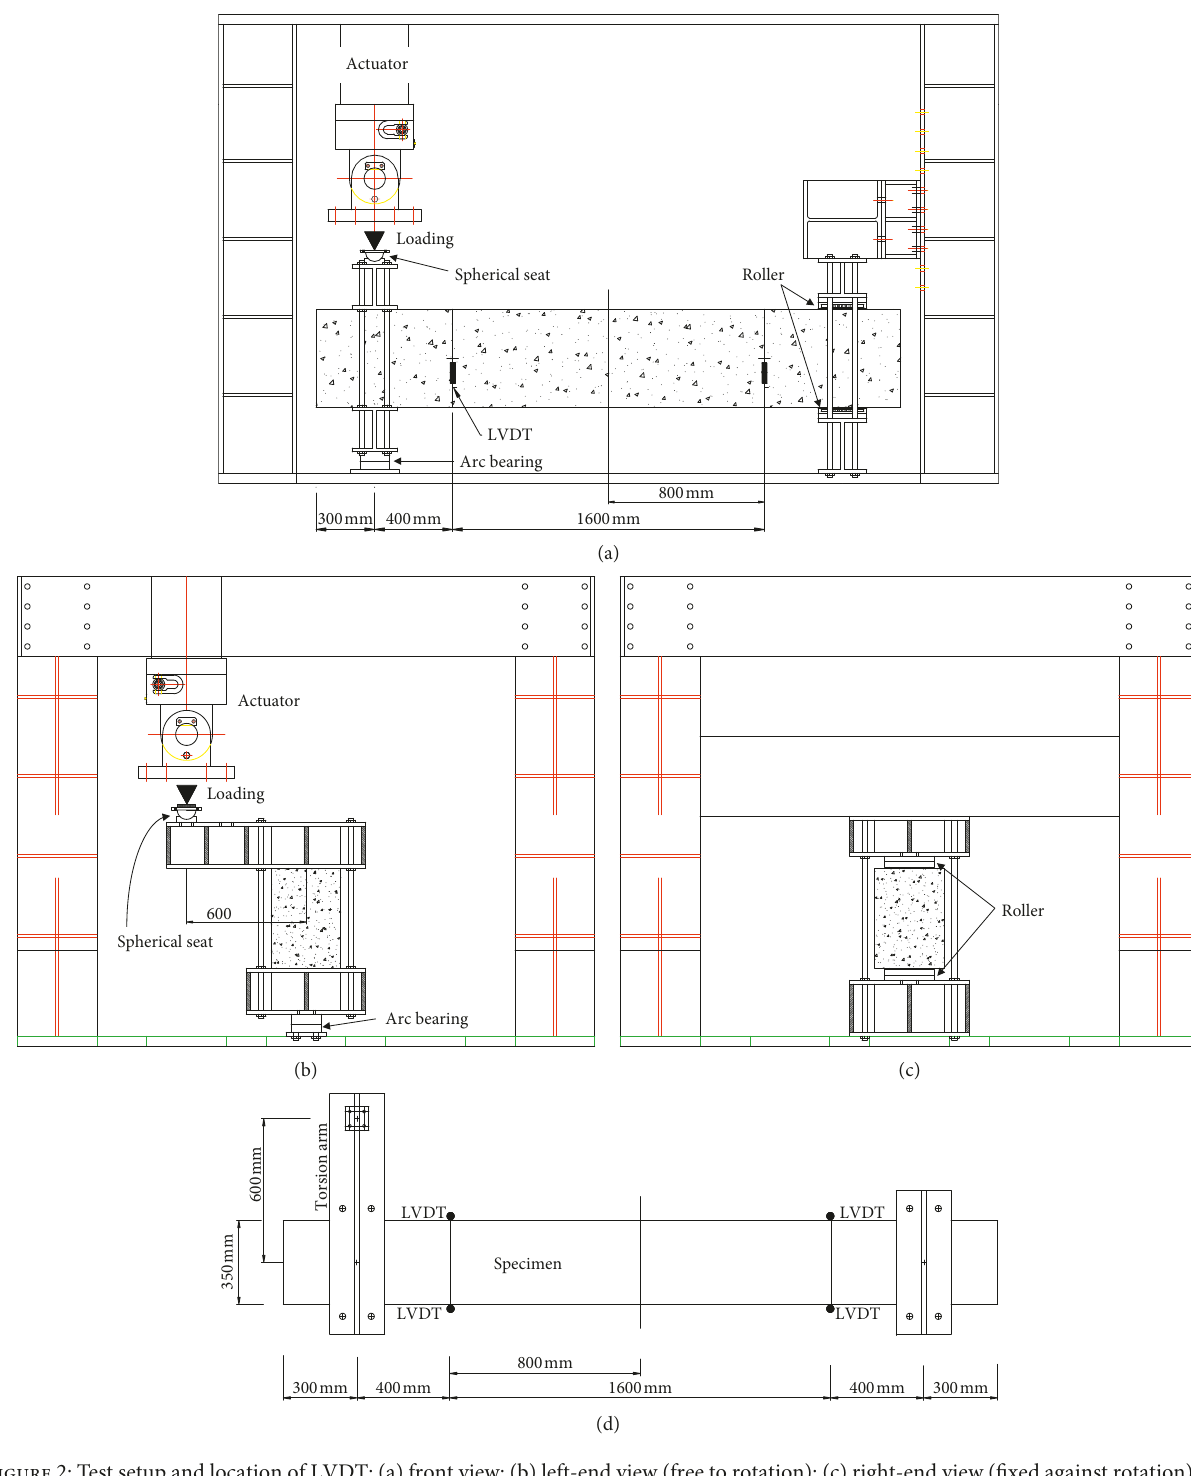
Figure 2: Test setup and location of LVDT: (a) front view; (b) left-end view (free to rotation); (c) right-end view (fixed against rotation); (d) top view of specimen and location of